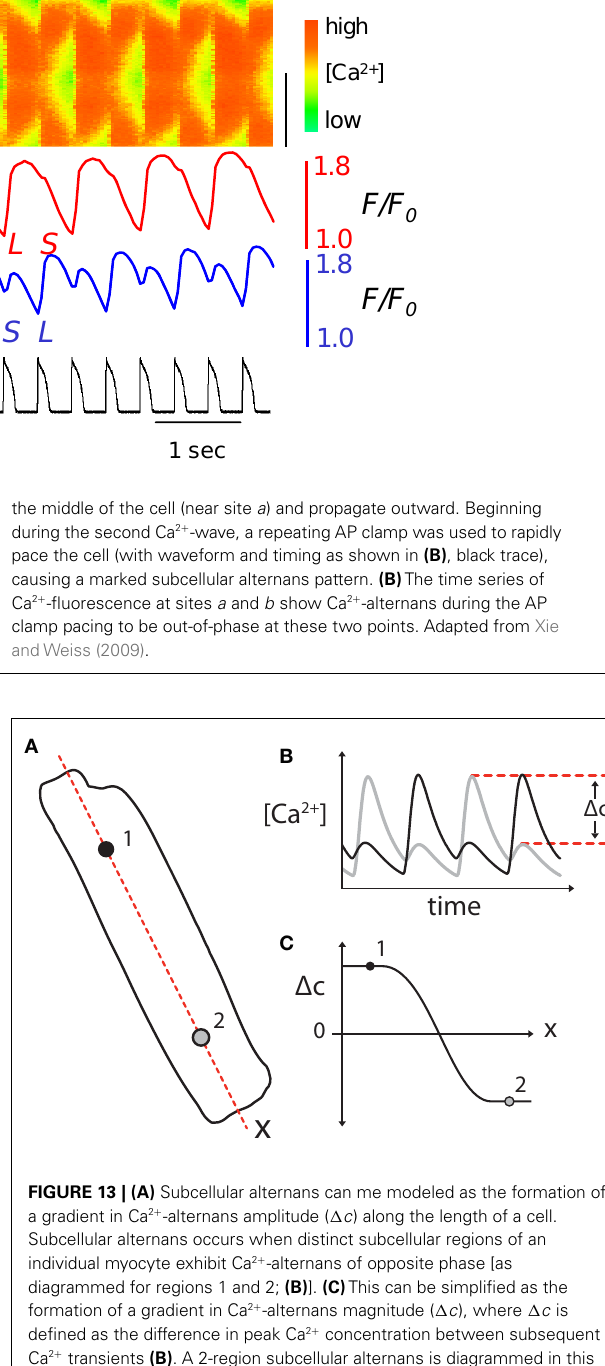
FIGURE 13 | (A) Subcellular alternans can me modeled as the formation of a gradient in Ca 2 + -alternans amplitude ( Δ c ) along the length of a cell. Subcellular alternans occurs when distinct subcellular regions of an individual myocyte exhibit Ca 2 + -alternans of opposite phase [as diagrammed for regions 1 and 2; (B) ]. (C) This can be simplified as the formation of a gradient in Ca 2 + -alternans magnitude ( Δ c ), where Δ c is defined as the difference in peak Ca 2 + concentration between subsequent Ca 2 + transients (B) . A 2-region subcellular alternans is diagrammed in this example, in which Ca 2 + transients in the two halves of the cell alternate out-of-phase, separated by a “node” with period-1 (no alternans) Ca 2 + transients where Δ c = 0. Adapted from Gaeta et al.